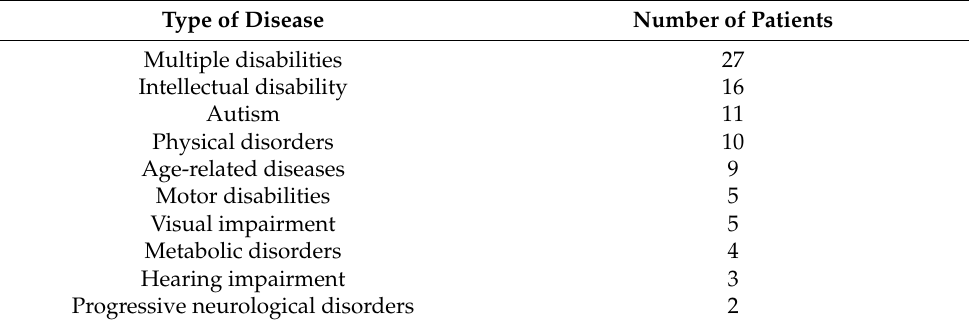
Figure 6. Distribution of thermal sensation responses according to the sex of respondents. Table 5. List of diseases among the APEI patients.